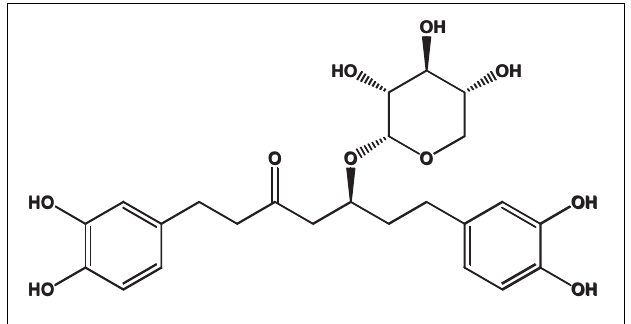
FIGURE 1 | Chemical structure of oregonin. This figure was made with ChemDraw (http://www.perkinelmer.com/category/chemdraw) (Choi, 2019).